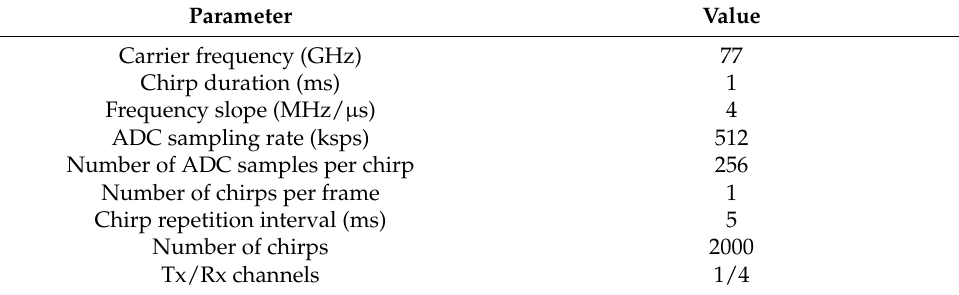
Table 1. Radar configuration parameters for heart sound measurements.